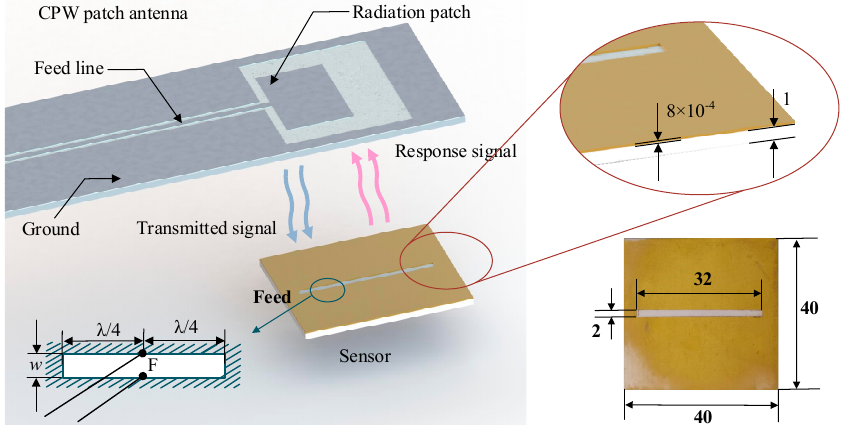
Figure 5. The electromagnetic principle of the sensor measurement.